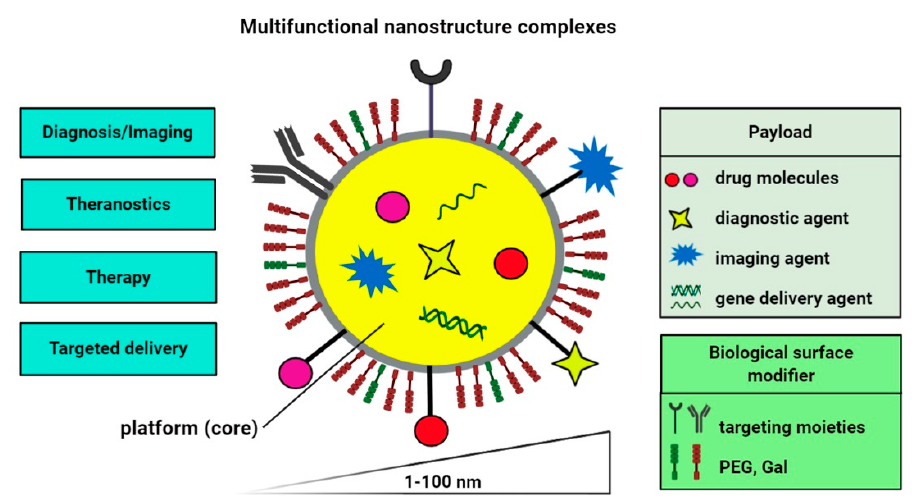
Figure 2. Schematic illustration of nanostructure-based multifunctional complexes. Cargos such as diagnostic probes (e.g., fluorescent or chromogenic dyes, radiotracers, or contrast agents), therapeutic agents (e.g., drugs, siRNA, natural compounds, or chemotherapeutics), surface coating (e.g., PEG, Gal, or mesoporous silica) and targeting ligands (e.g., antibodies or aptamers) can be attached / encapsulated to nanostructures using chemistry and surface modification methods. PEG, polyethylene glycol; Gal, galacto-oligosaccharides.